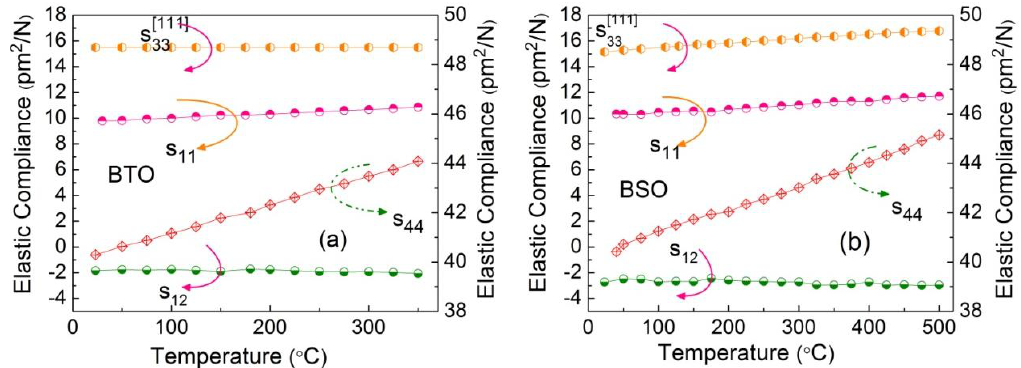
Figure 7. Elastic compliance as a function of temperature for BTO and BSO crystals.